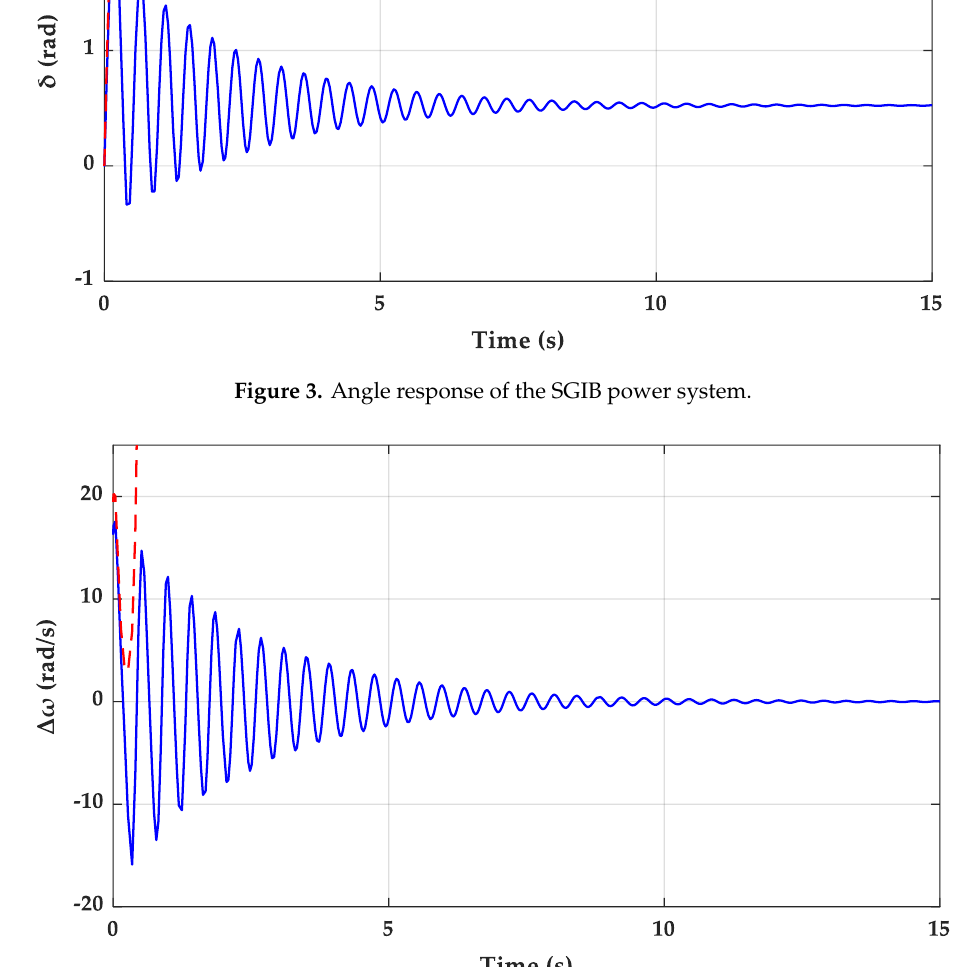
Figure 4. Response of the angular speed of the SGIB power system.